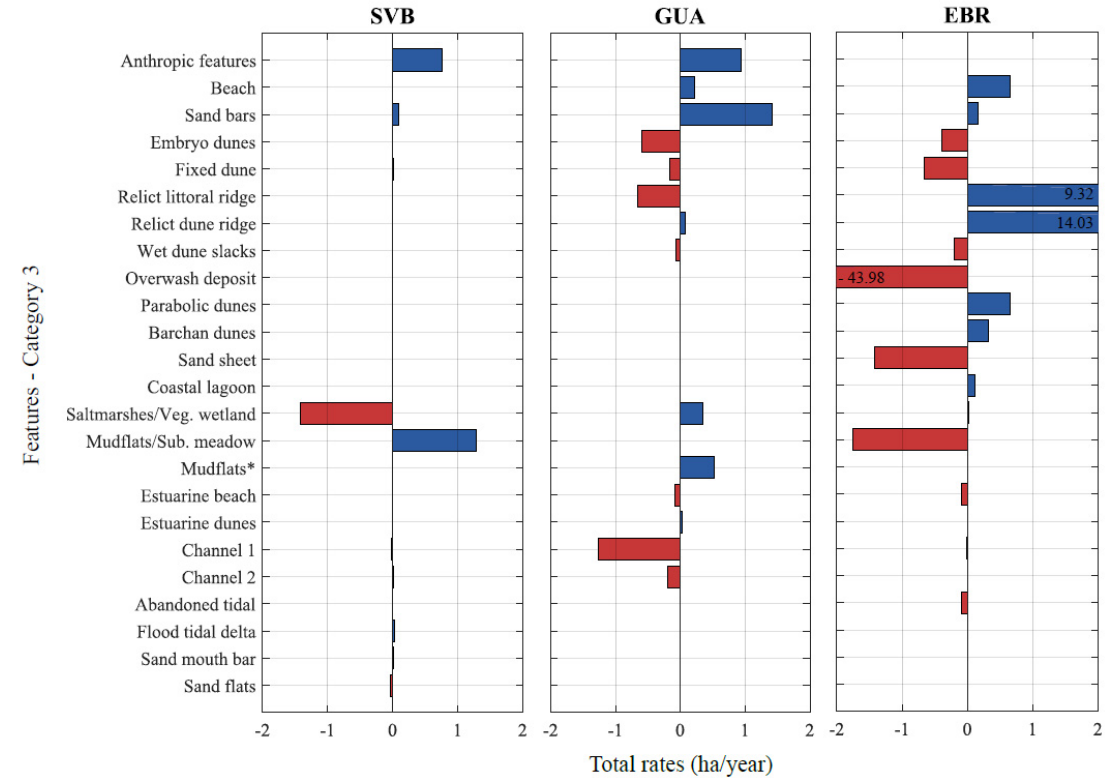
Figure 8. Total rates of change (ha/year) per feature (Categories 2 and 3) in the three study sites. To maintain the same x-scale for the three study sites, the total rates of change in the relict littoral ridge, relict dune ridge and overwash deposit in the EBR, which showed rates of change greater than ± 2 ha, are indicated numerically on each bar.